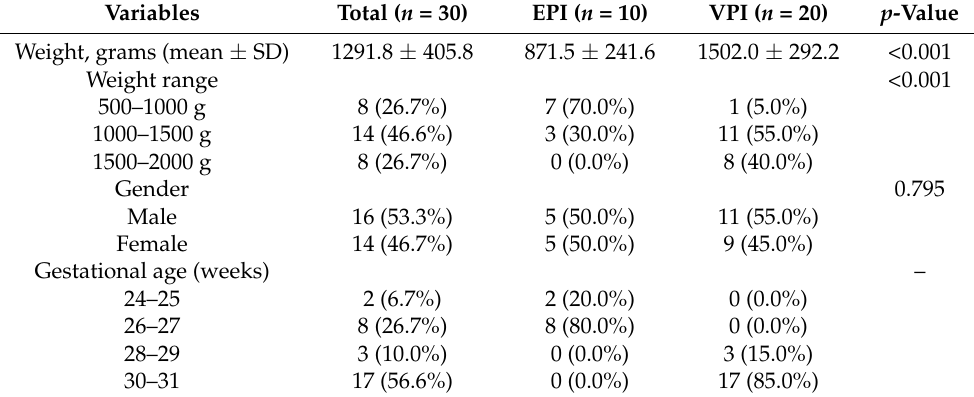
Table 1. The characteristics of EPI and VPI infants included in the study.